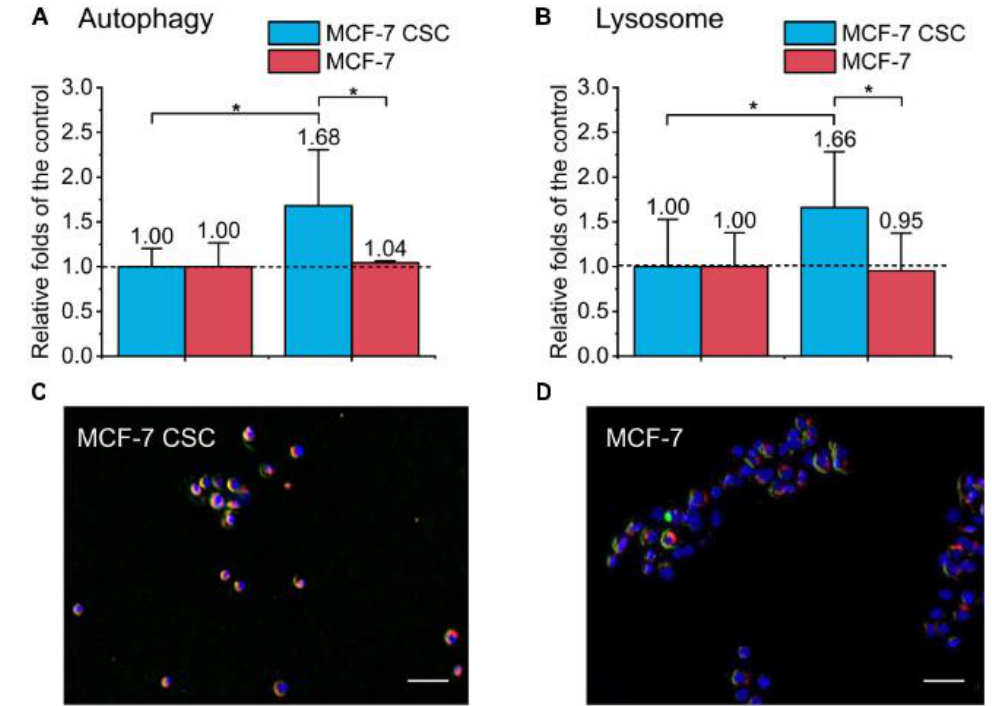
Figure 10. Detection of autophagy and lysosomes in the irradiated MCF-7 cells and MCF-7 CSCs. ( A ) Compared with the control, the increase in the autophagy proportion of the irradiated group. ( B ) Compared with the control, the increase in lysosomes of the irradiated group. All results are expressed as means ± SD, Student’s t-test or one-way ANOVA are used for analyzing significance between the controls and the experimental groups, where p < 0.05 was marked as *. ( C , D ) Representative images of irradiated MCF-7 cells and MCF-7 CSCs stained with MDC autophagy detection kit and lysoTracker Red DND-99. The blue is the nucleus, the red is the lysosome, and the green is labeled autophagy.